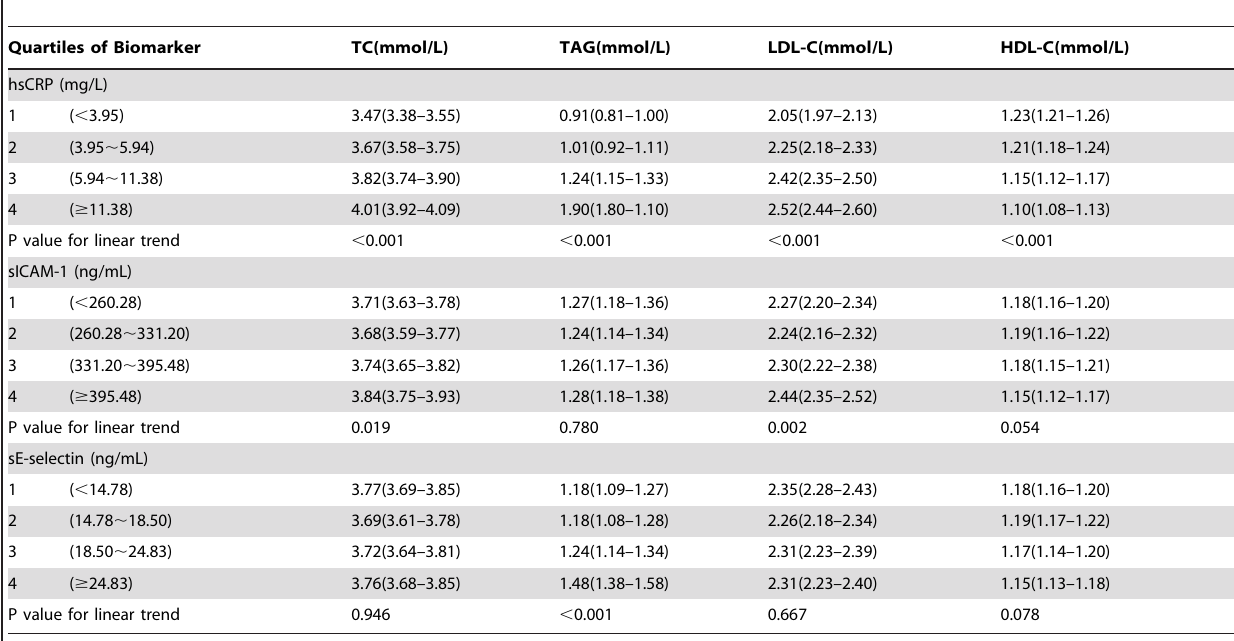
Table 3. Multivariable-adjusted Mean Levels (95% Confidence Intervals) of The Components of Dyslipidemia According to Quartiles of Inflammatory